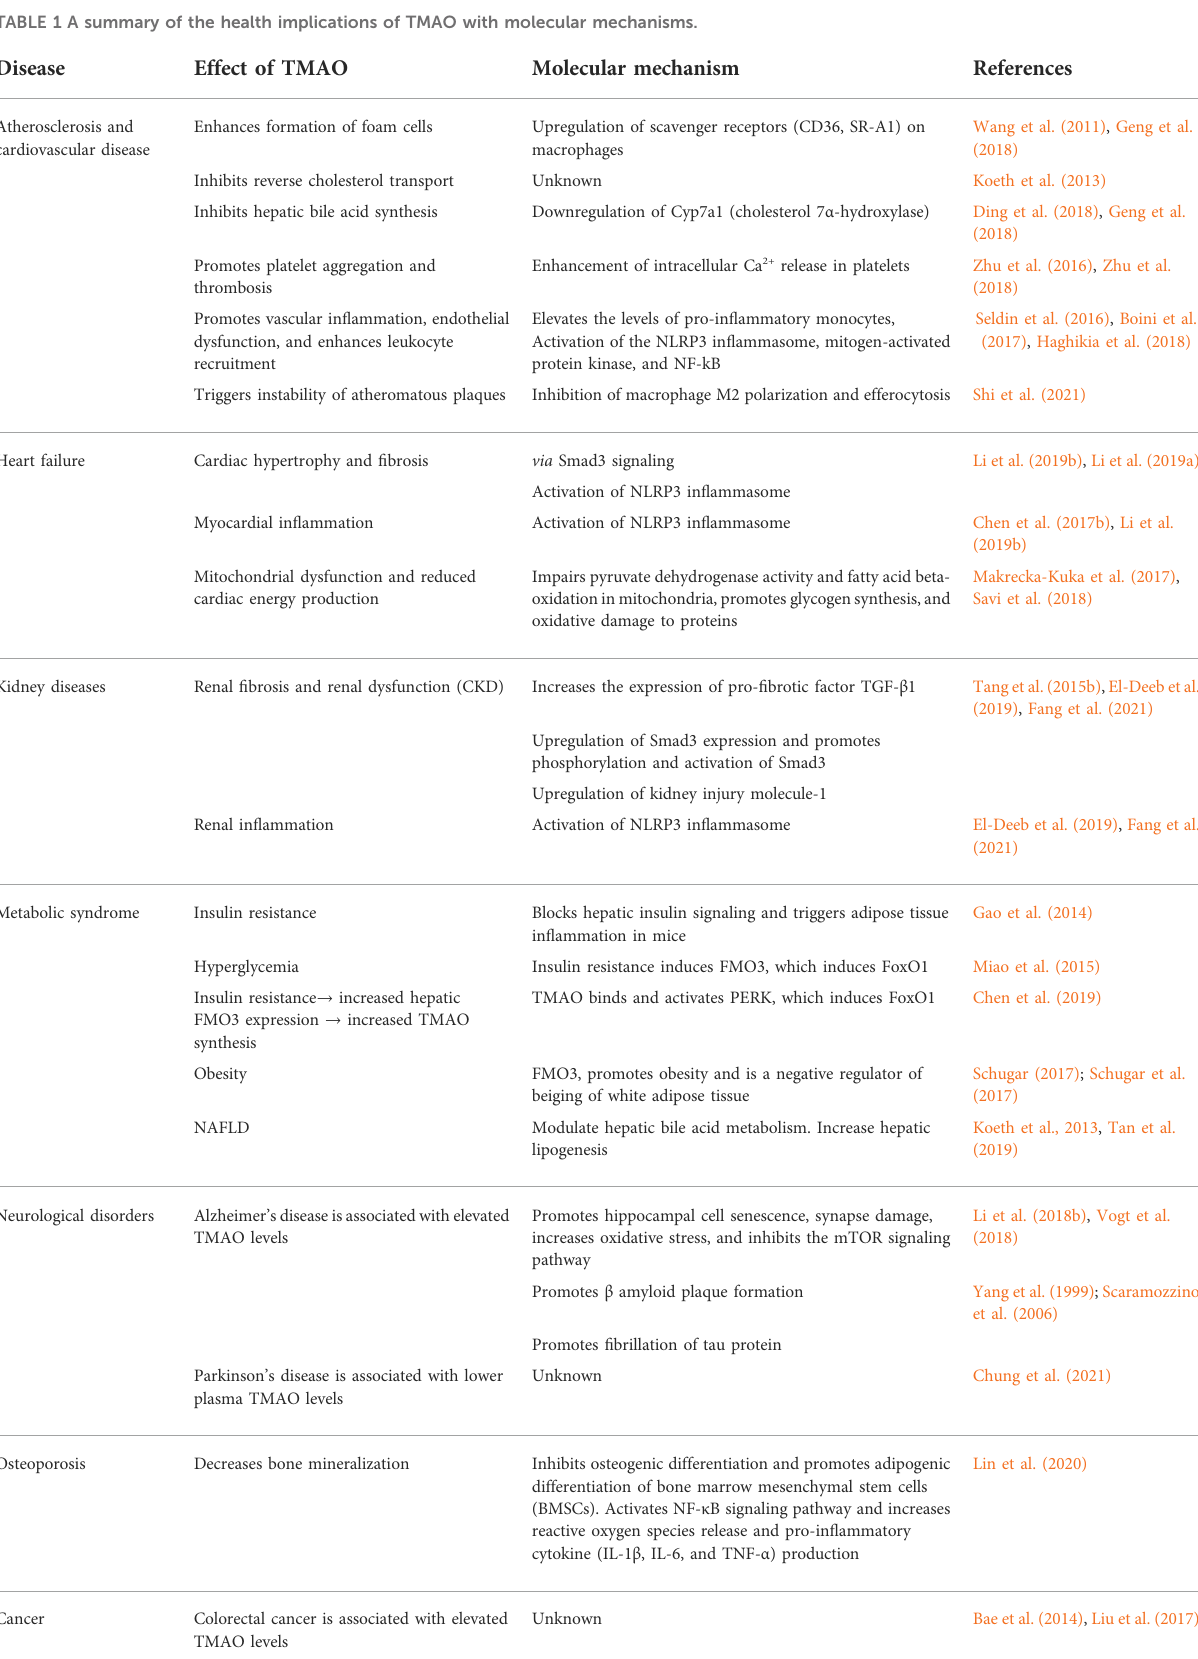
TABLE 1 A summary of the health implications of TMAO with molecular mechanisms.